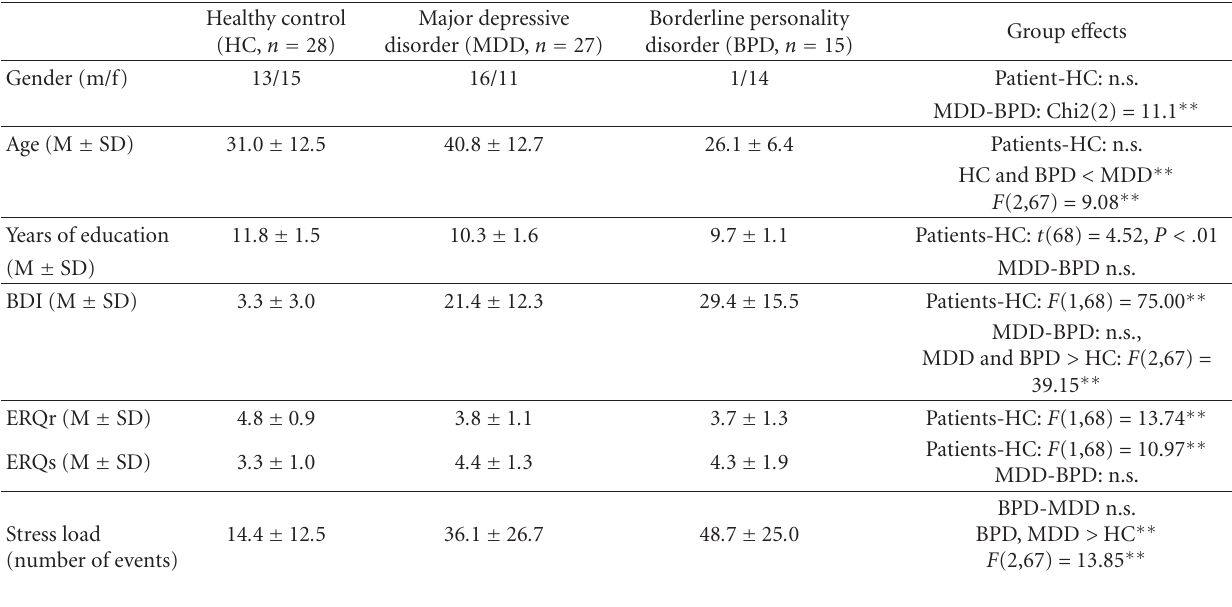
Table 1: Demographic and clinical information for